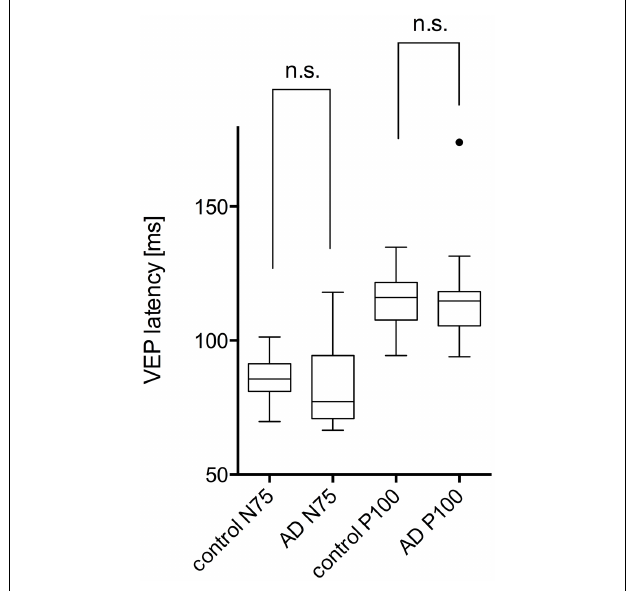
FIGURE 1 | Comparison ofVEP latencies (N75 and P100) of control patients (marked as control) andAD patients (marked asAD) . No significant (marked as n.s.) differences were found between the two groups ( P -value > 0.05). Data is presented as aTukey box-and-whiskers plot, with values that are above or below the whiskers drawn as individual dots.